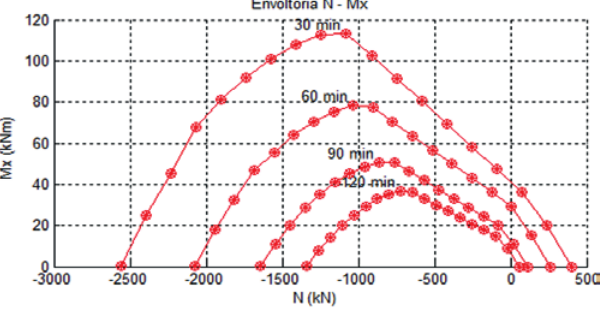
Figura 16a Curvas de interação N x M cm com 4 ϕ 16 mm